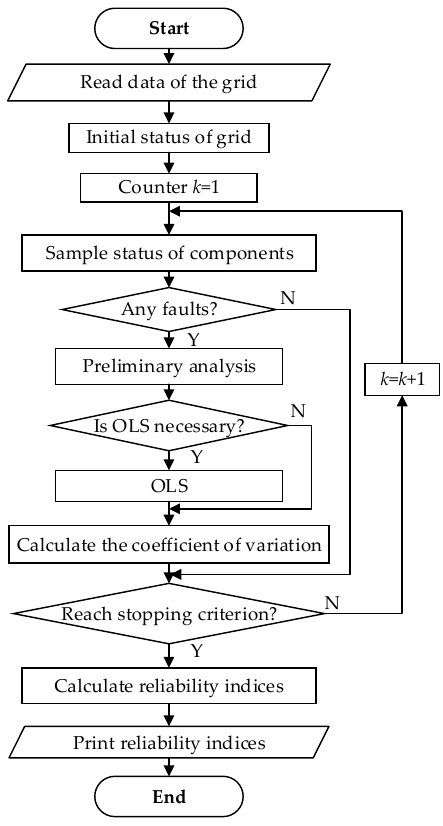
Figure 7. Reliability evaluation procedure of HVDC grids